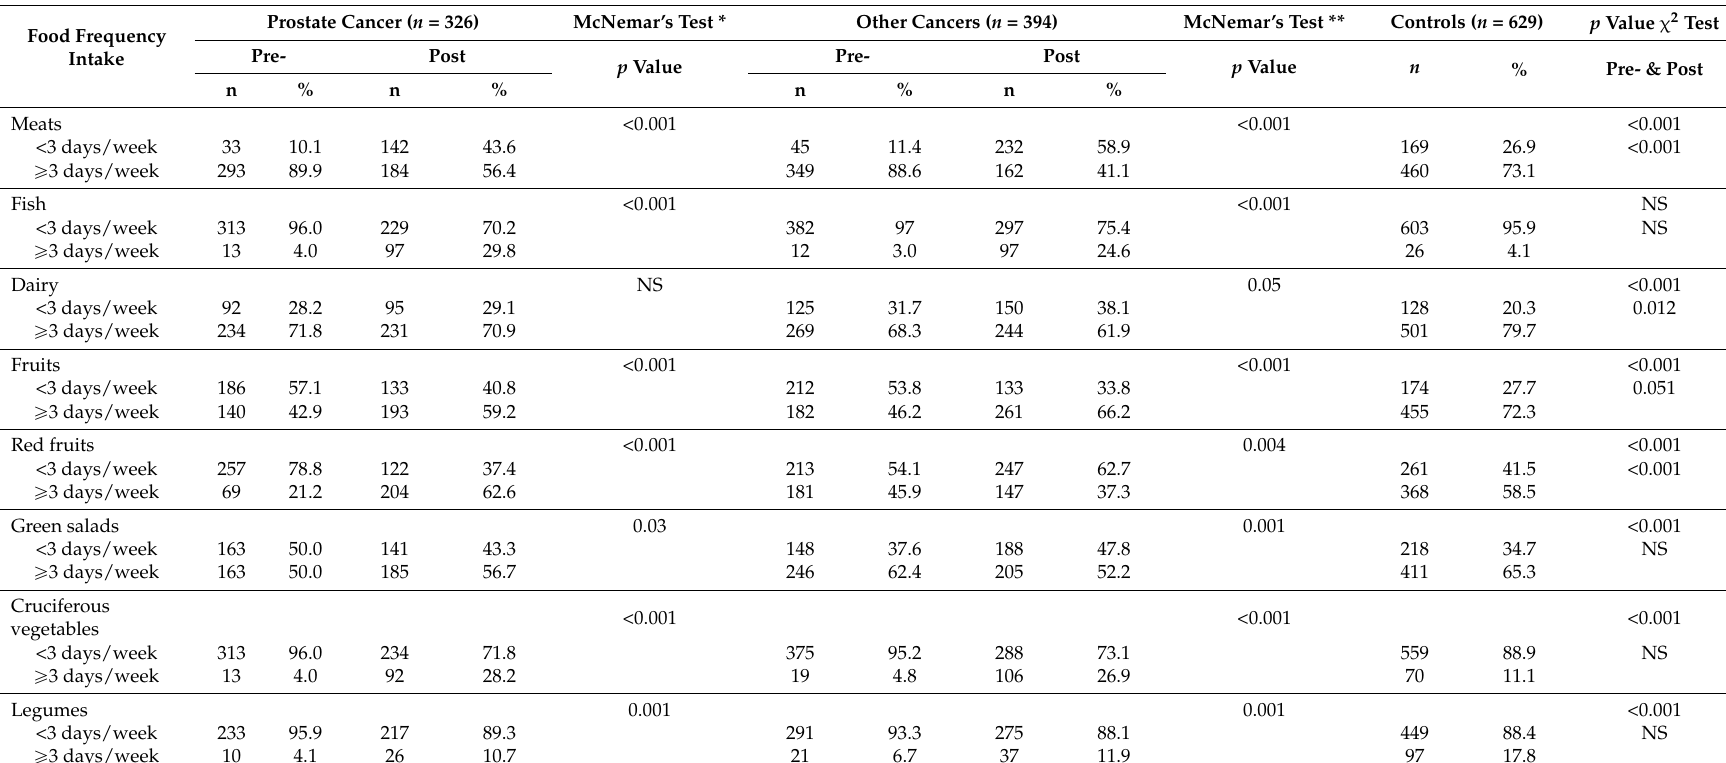
Table 2. Dietary habits pre- and post-diagnosis of